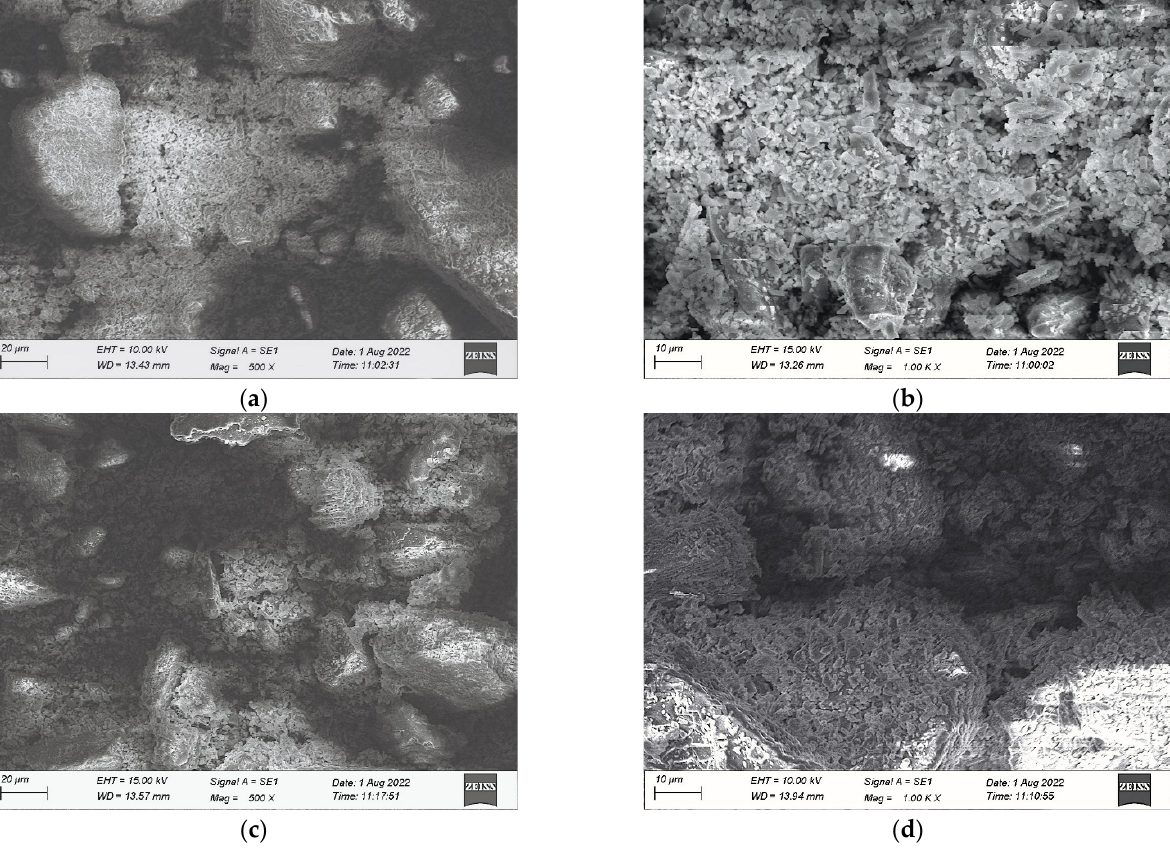
Figure 7. Microscopic images of SP and SCESP. ( a ) SCESP × 500; ( b ) SCESP × 1000; ( c ) SP × 500; ( d ) SP × 1000. Table 6. Main components of SP and SCESP.